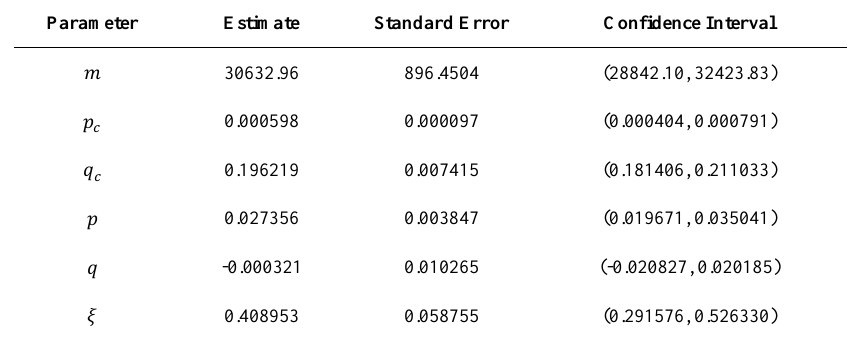
Table 8. Emilia–Romagna. Estimates, asymptotic standard errors and 𝟗𝟓% mCIs for the parameters of the DMPsw